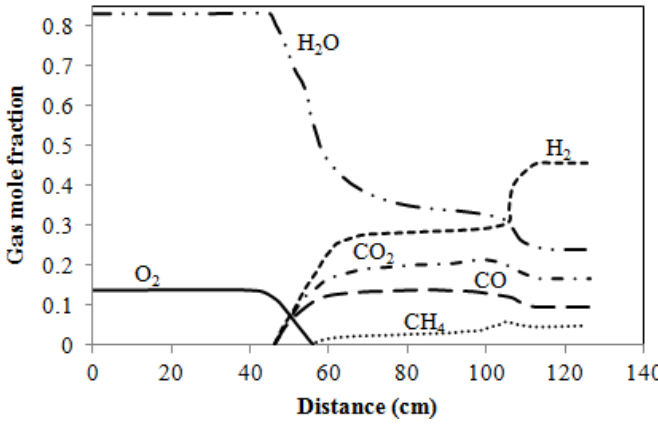
Figure 5. Calculated gas phase concentration at time = 1.4 × 10 4 s for the 1.5 m reactor simulation [48].